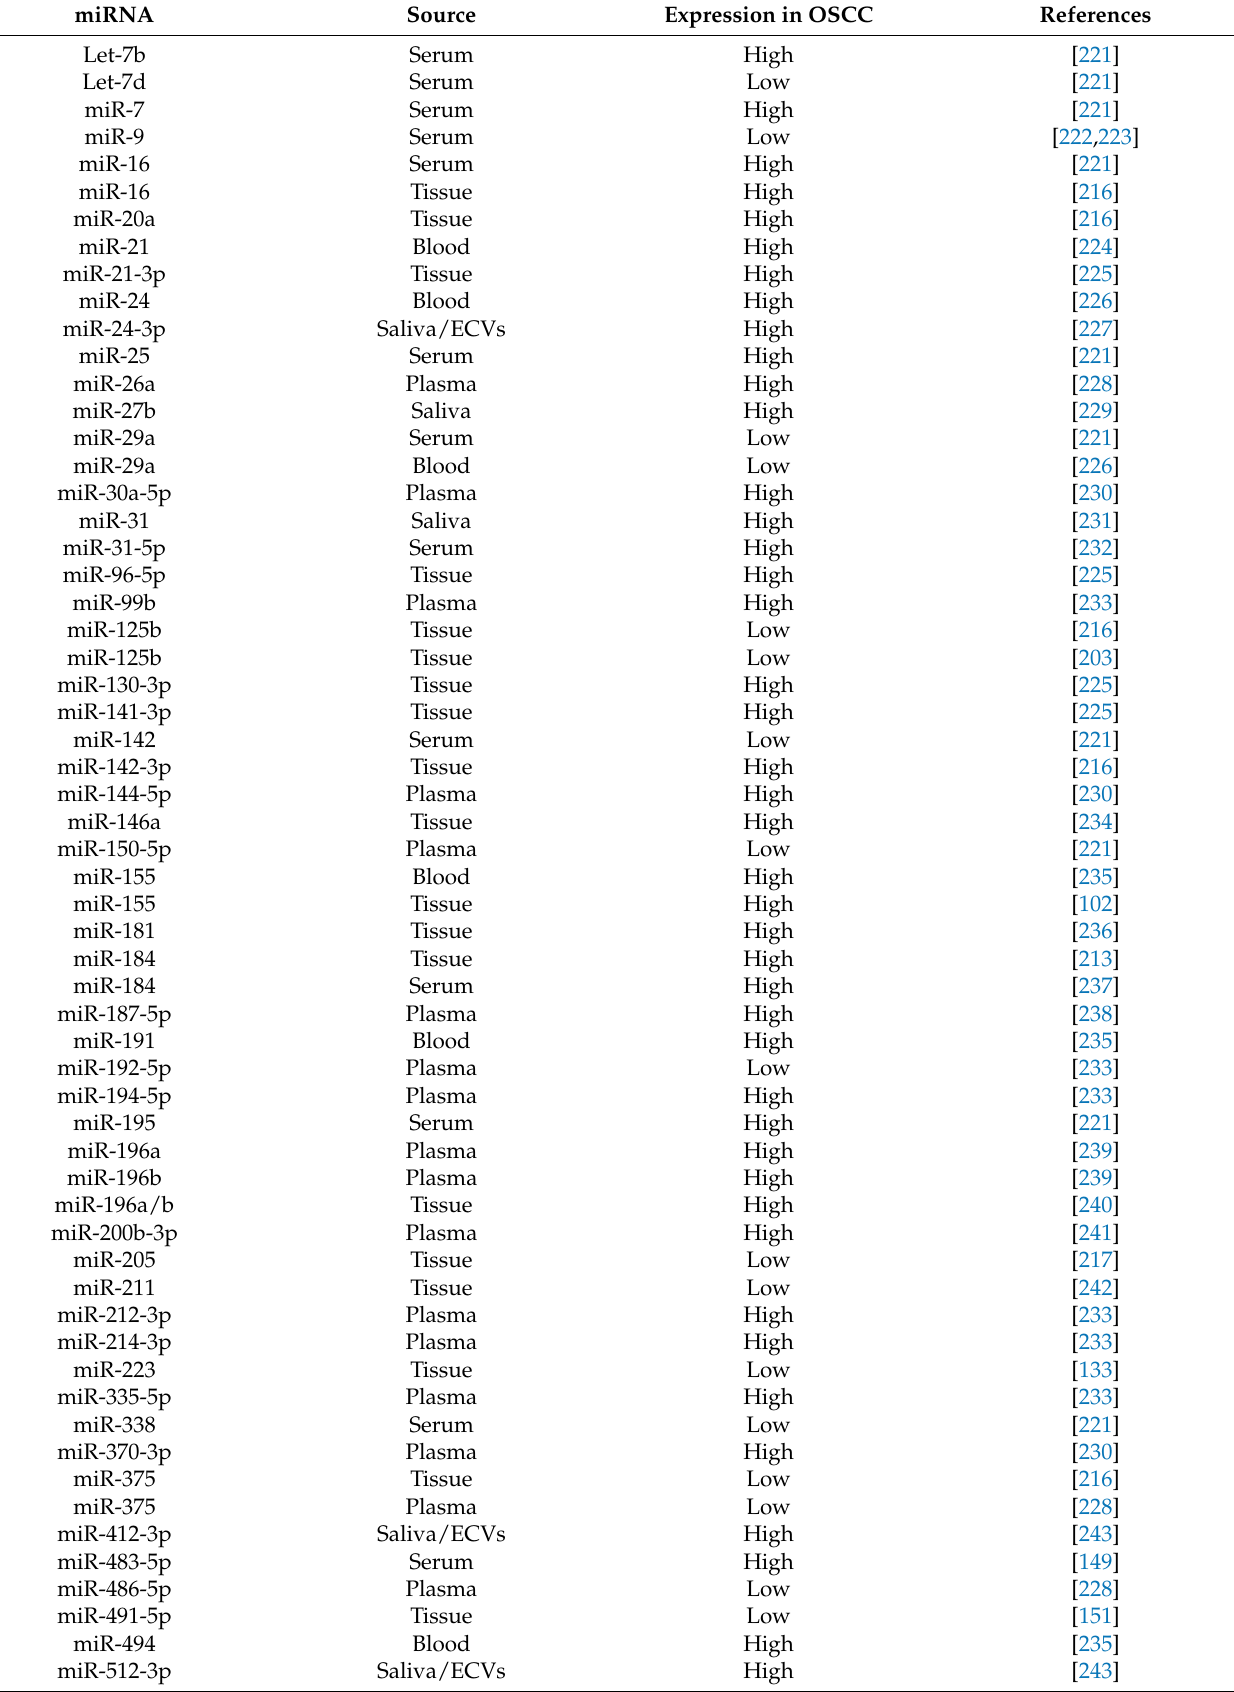
Table 2. MicroRNAs as diagnostic biomarkers in oral